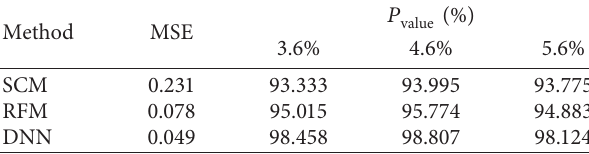
Table 6: Precisions of different preprocessing